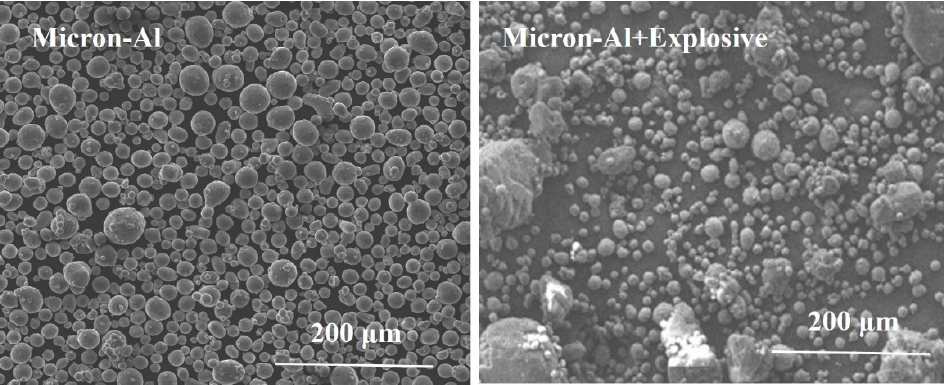
Figure 7. SEM images of micron-Al and explosive containing micron-Al.